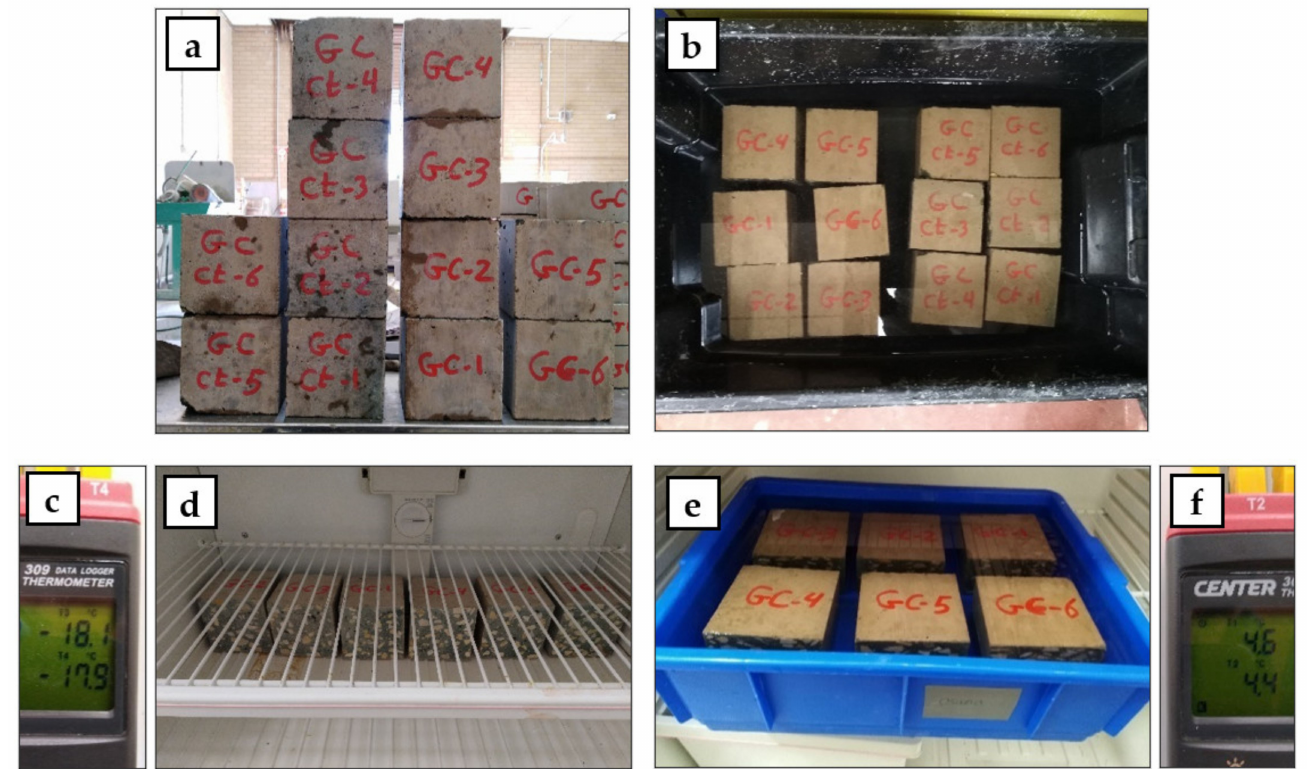
Figure 3. Freezing-thawing test specimens and procedures: ( a ) specimen preparation, ( b ) spec- imen curing, ( c ) freezing temperature, ( d ) specimen freezing, ( e ) specimen thawing, and ( f ) thawing